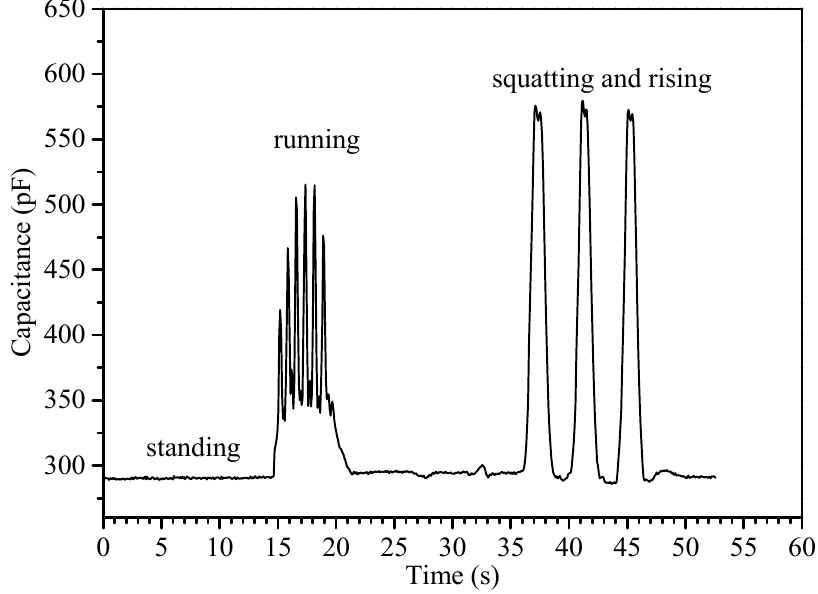
Figure 9. Typical capacitance changes measured with the flexible sensor while monitoring human knee motion over different large flexion angle movements.